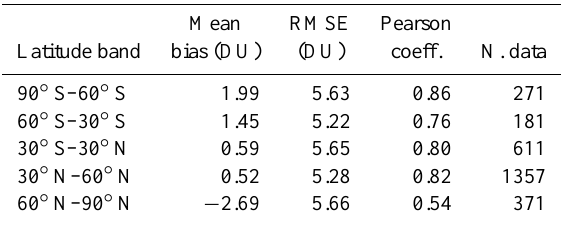
Table 3. Retrieval results on the test set, stratified by latitude